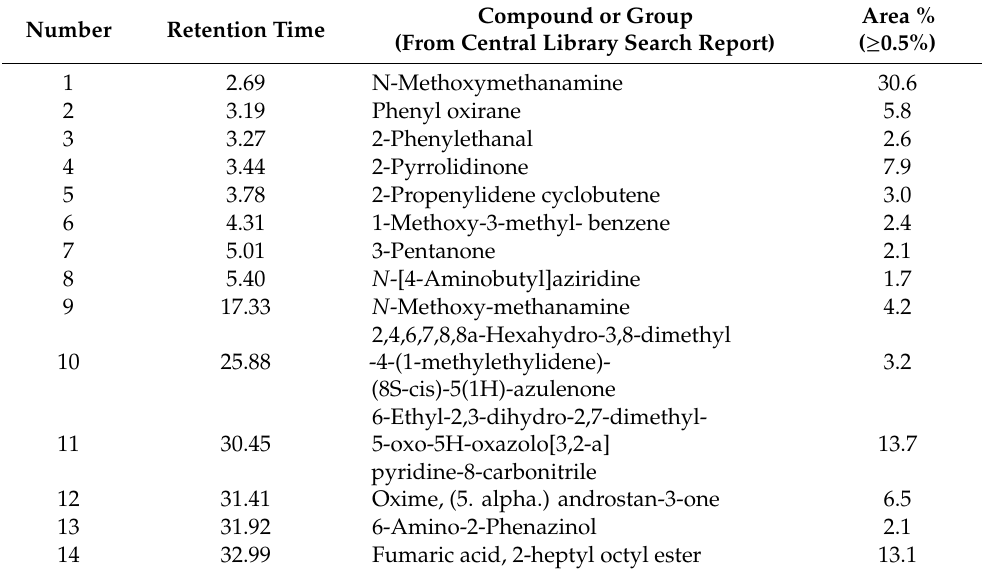
Figure 3 . GC-MS analysis of A. bisporus aqueous extract .